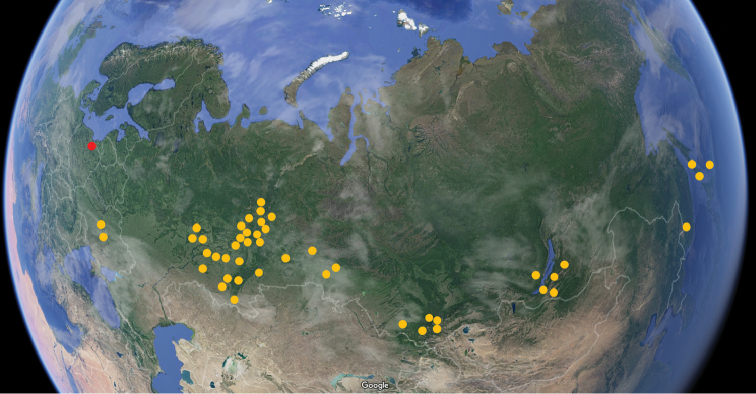
Distribution map of Lithobiusproximus Sseliwanoff, 1878 based on a summarisation of the published data (yellow dots; Zalesskaja 1978, Zalesskaja and Golovatch 1996, Chornyi and Kosyanenko 2003, Farzalieva and Esyunin 2008, Kosyanenko and Chornyi 2008, Kunakh 2013, Sergeeva 2013, Nefediev et al. 2017a, b, Nefediev et al. 2018) and our records (red dot; this paper).